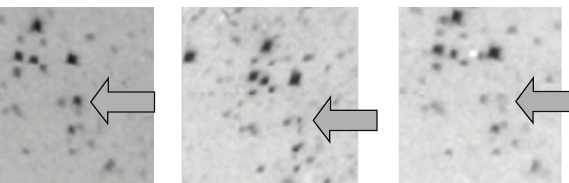
Figure 3: IGR J12349-6434 = RT Cru, hard X-ray symbiotic star, on Leiden Franklin Adams Plates. INTEGRAL gamma-ray source visible on astronomical plates taken by 100 years old optical telescope. Violent (amplitude 3 magnitudes) optical brightness variations about 80 years ago.